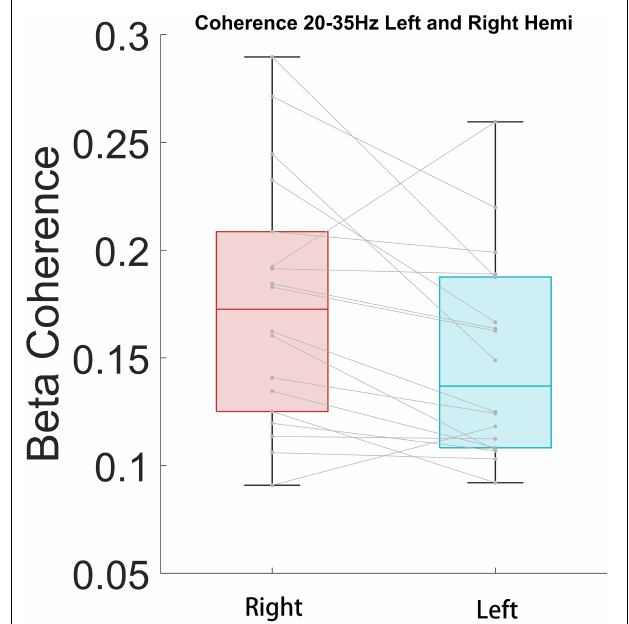
FIGURE 7 | High beta coherence is significantly higher for ipsilateral STN/cortical pairs than contralateral pairs ( P < 0.05).